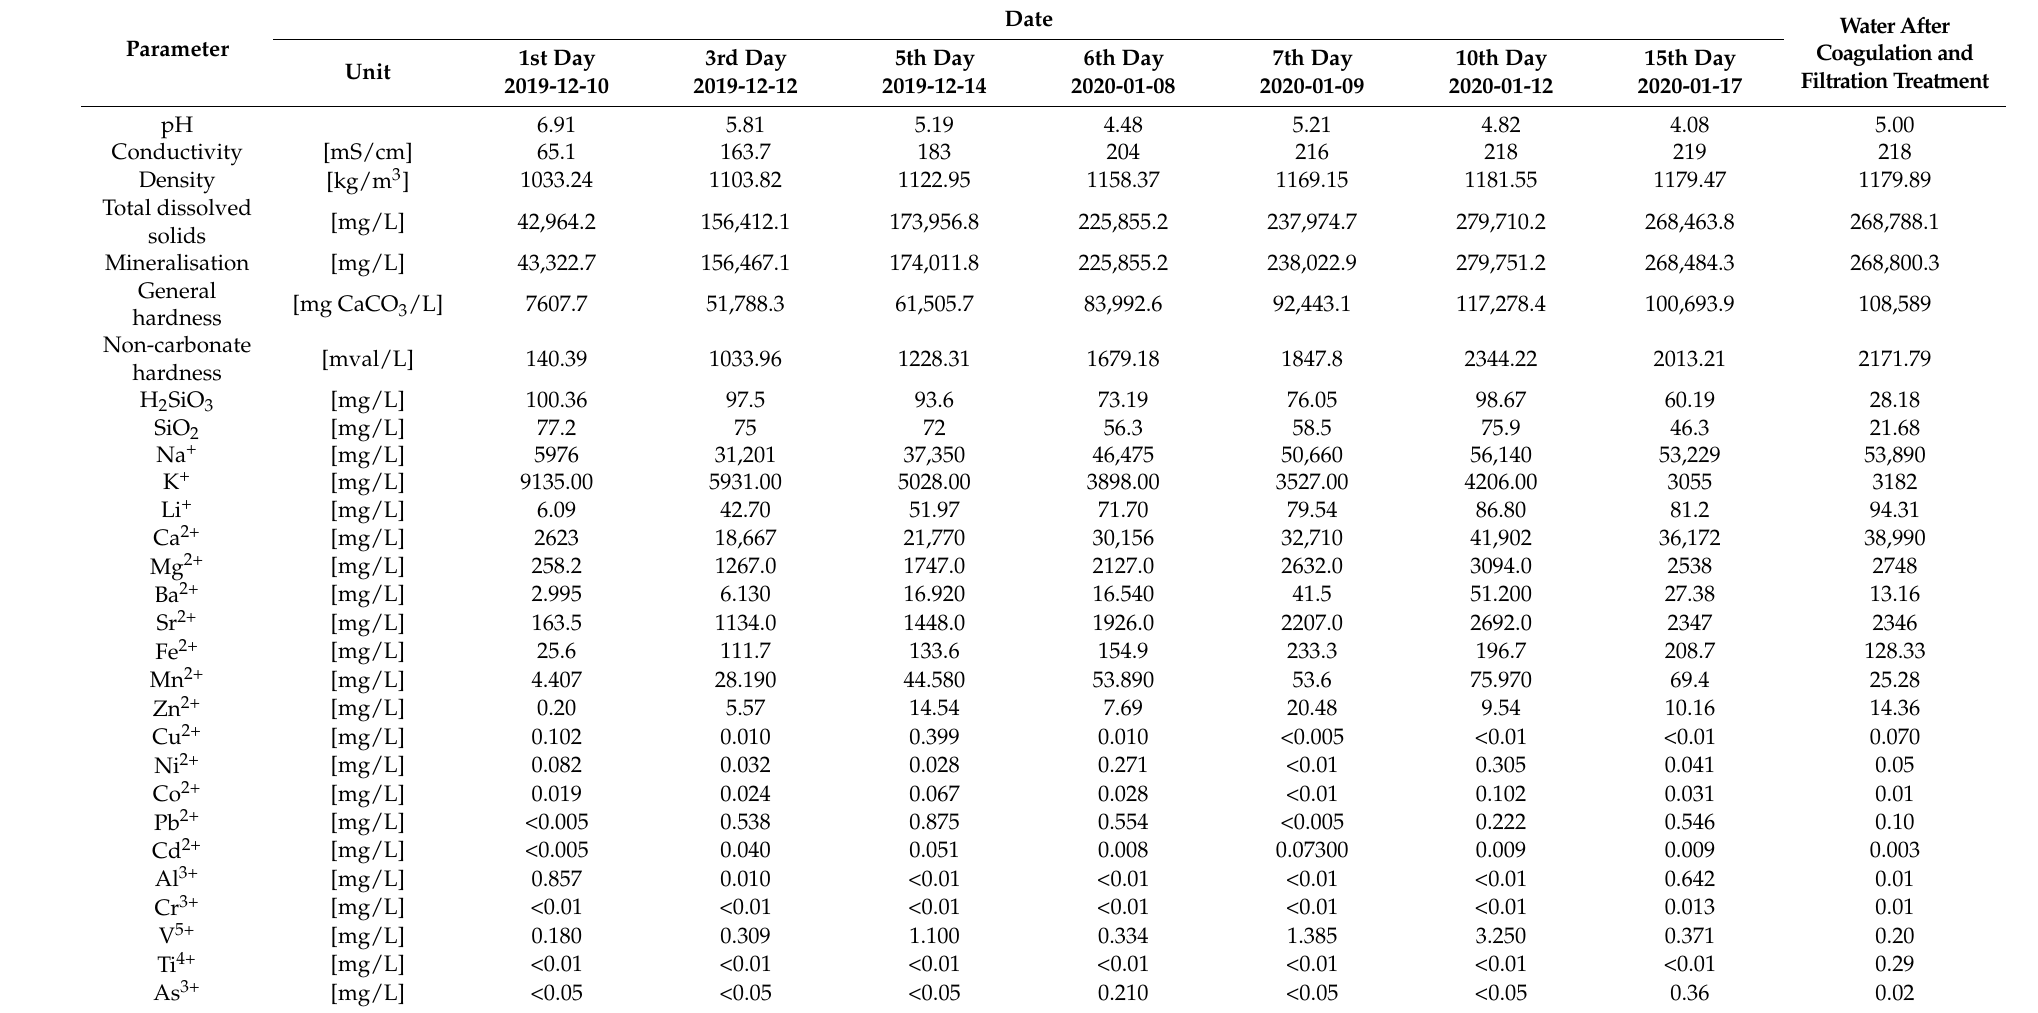
Table A2. Selected parameters and composition of raw and treated